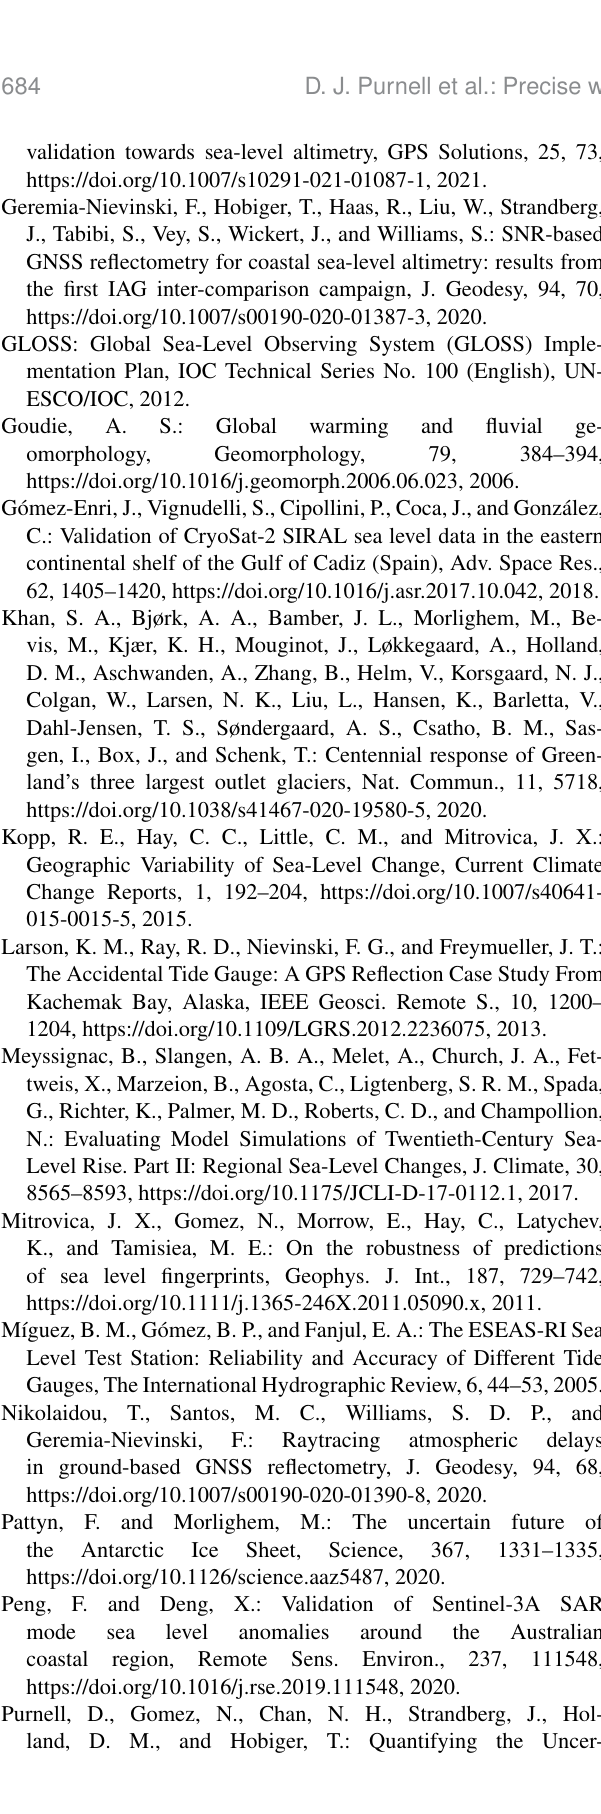
Tabibi, S., Nievinski, F. G., Dam, T. V., and Monico, J. F.: As- sessment of modernized GPS L5 SNR for ground-based mul- tipath reflectometry applications, Adv. Space Res., 55, 1104– 1116, https://doi.org/10.1016/j.asr.2014.11.019, 2015. Tabibi, S., Geremia-Nievinski, F., Francis, O., and van Dam, T.: Tidal analysis of GNSS reflectometry applied for coastal sea level sensing in Antarctica and Greenland, Remote Sens. En-